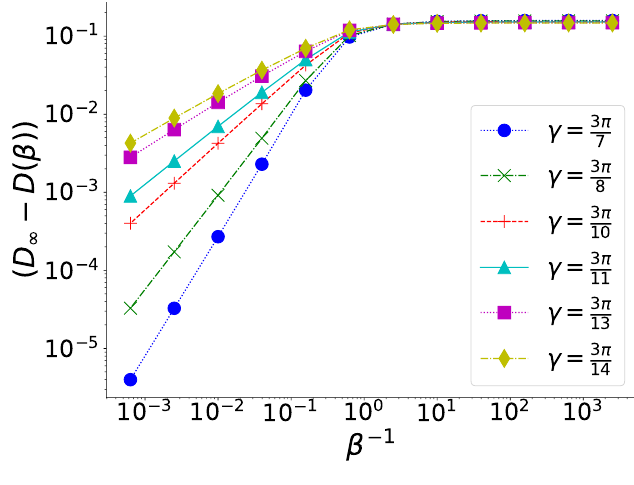
Figure 2: Absolute difference between the Prosen bound β − 1 D β → Drude weight coefficient β − 1 D demonstrating convergence to the Prosen bound. Note the crossover between curves for different anisotropies at β − 1 ≈ 0.5 in the left panel. A power-law scaling consistent with | D ( β ) − D β → is observed, agreeing with the TBA result see Eq. (52).